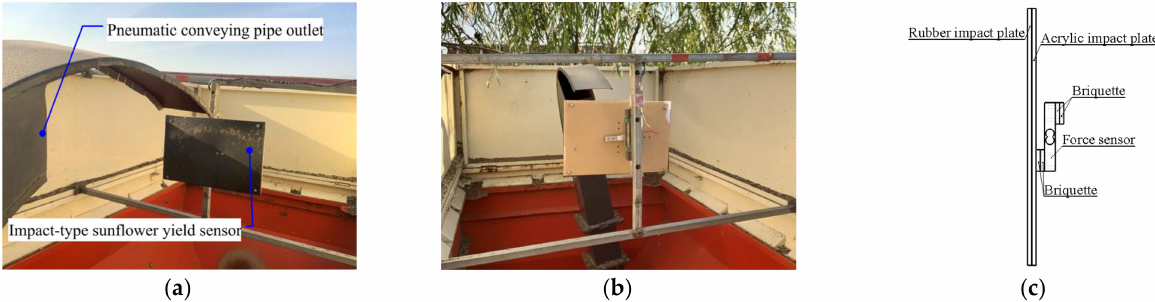
Figure 2. Impact-type sunflower yield sensor: ( a ) Front view; ( b ) Rear view; ( c ) Structure